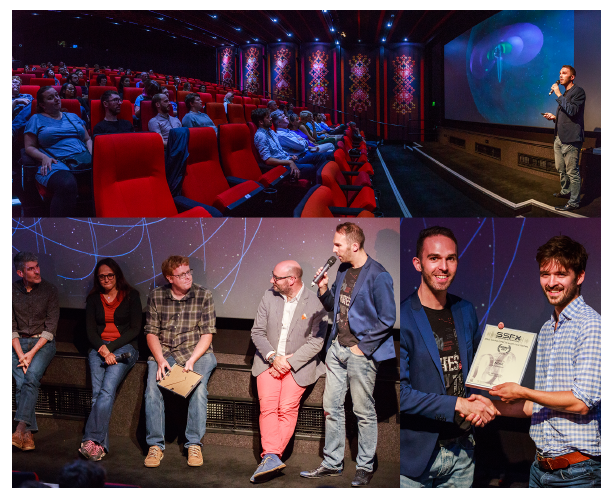
Figure 3. Photos from the SSFX Short Film Festival. The top panel shows the presentation about the underlying science. The bottom- left panel shows panel discussions between scientists and filmmak- ers. The bottom-right panel shows the awarding of prizes to film-